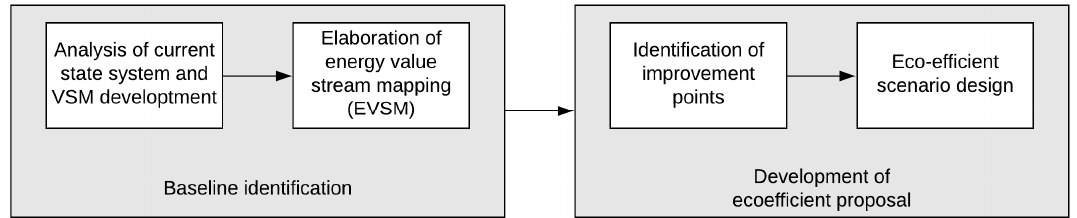
Figure 5. Monitoring of the VSM development stages of the current study.